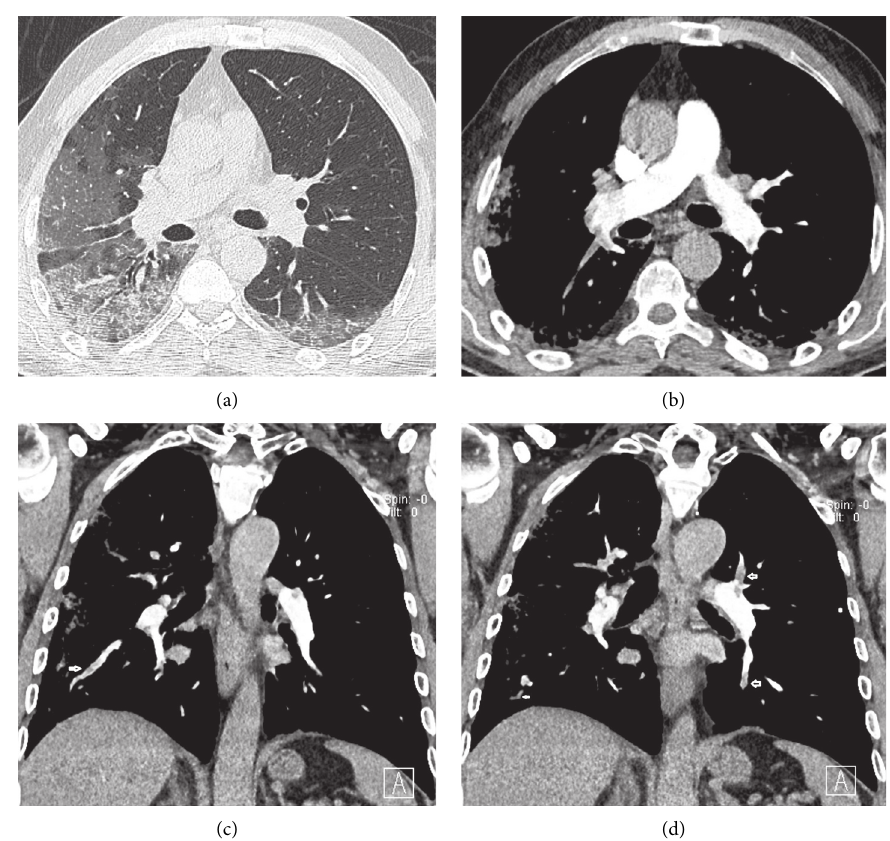
Figure 3: Images in a 64-year-old man with COVID-19 pneumonia complaining of body ache, fever, and cough. (a) Axial unenhanced chest CTscan (lung window) obtained on day 9 after the onset of symptoms shows bilateral areas of peripheral ground-glass opacities more at the right side with interlobular septal thickening (crazy paving sign), vascular sign, and air bronchogram sign being seen. (b) Axial CT pulmonary angiography scan. (c, d) Coronal reformatted images (mediastinum window) on day 24 after the onset of symptoms demonstrate multiple bilateral filling defects (white arrows) involving lobar, segmental, and subsegmental branches of the pulmonary